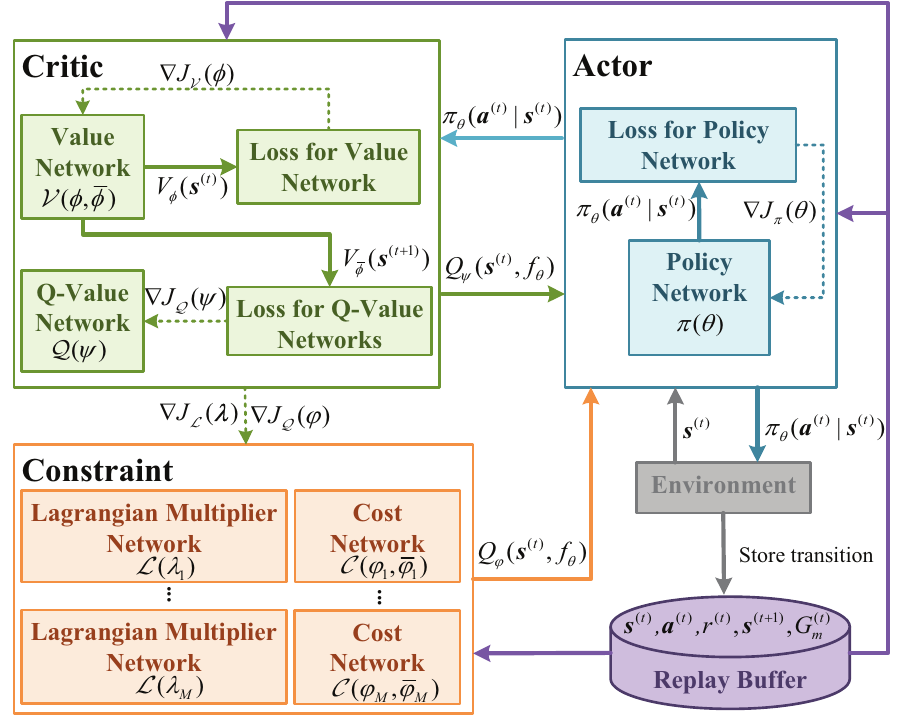
Figure 3. The architecture of proposed AL-SAC